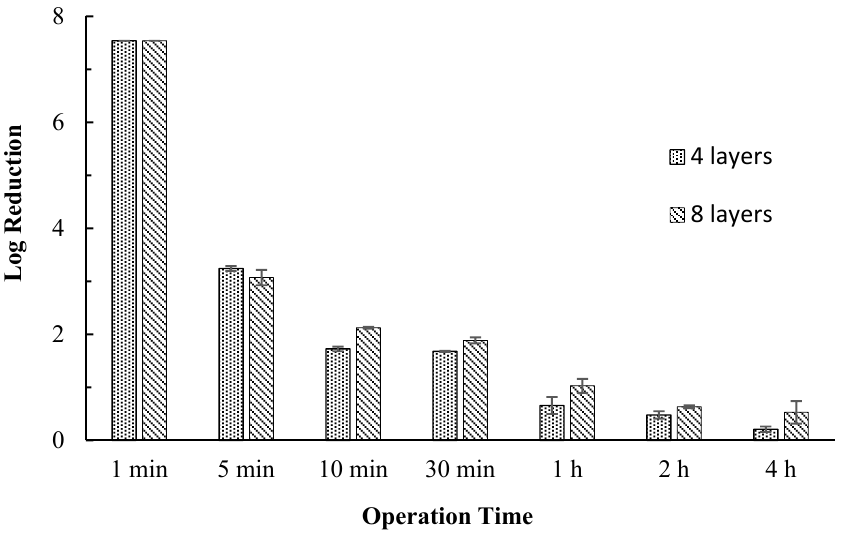
Figure 3. Bacterial log reduction by REM treatment with 4 or 8 ACFC layers at 10 mL/min and 10 V under continuous operation.